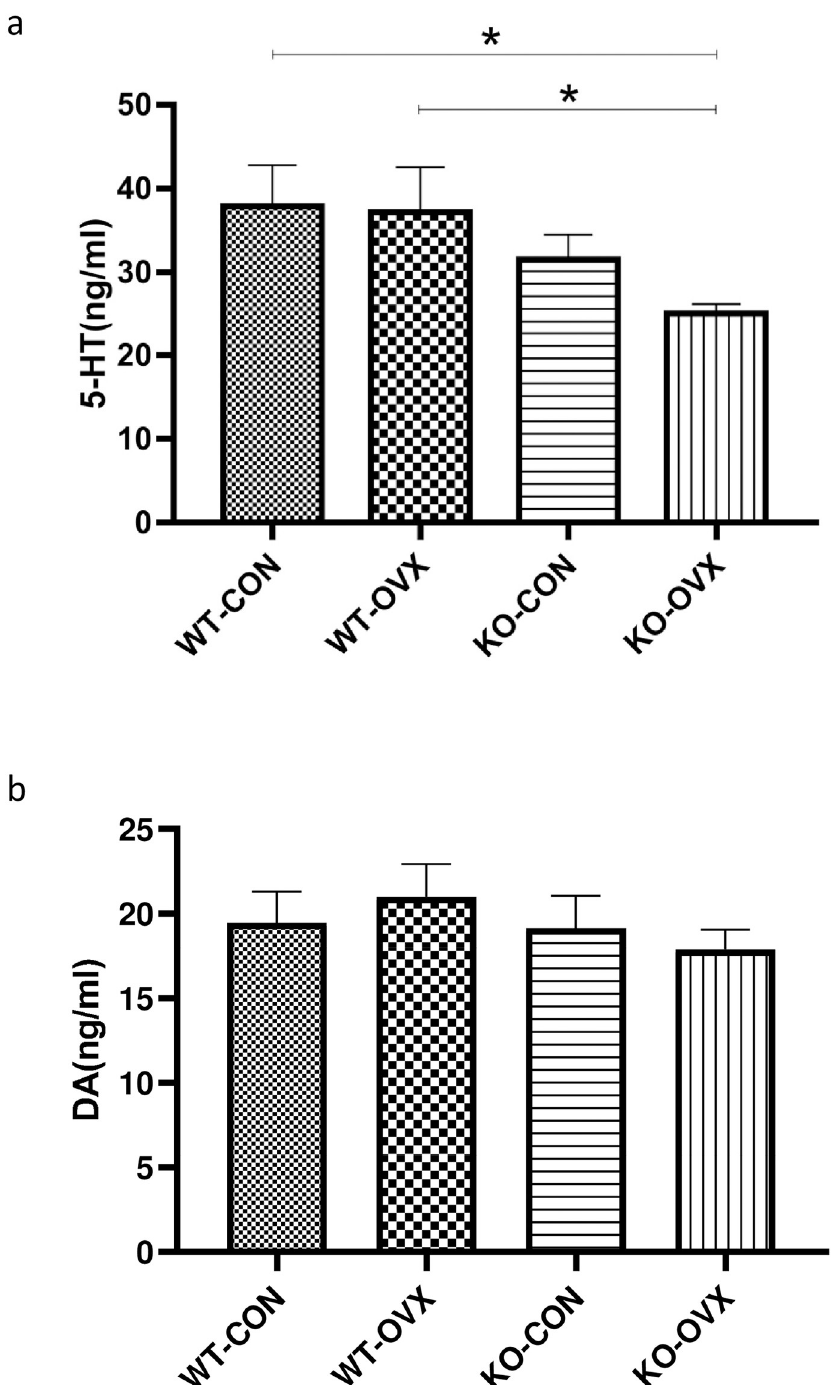
Fig 5. Concentrations of neurotransmitters in the brain tissues of different groups of mice. WT-CON: wild-type control, WT-OVX: wild-type ovariectomy, KO-CON: Nrf2−/− control, KO-OVX: Nrf2−/− ovariectomy. (a) Concentrations of 5-hydroxytryptamine (5-HT) in the brain tissues of different groups of mice at postoperative week 9. (b) Dopamine (DA) concentrations in the brain tissues of different groups of mice at postoperative week 9. Results are shown as mean ± SEM. � P < 0.05 analyzed by One-way ANOVA with Bonferroni’s Multiple comparison test.